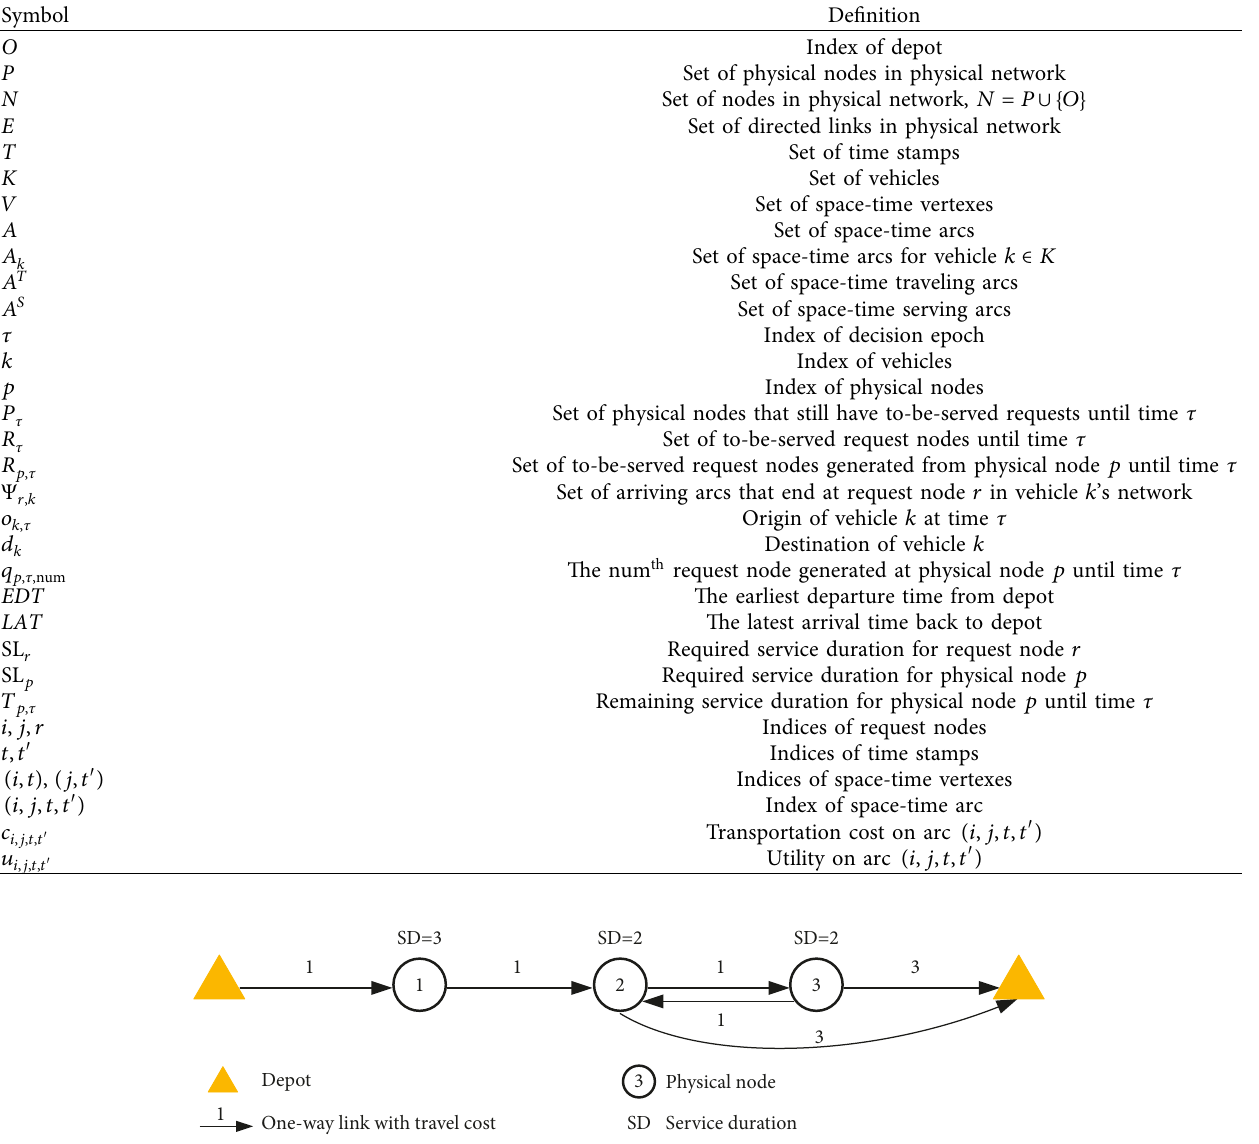
Table 2: Sets, indexes, and parameters for model establishment.